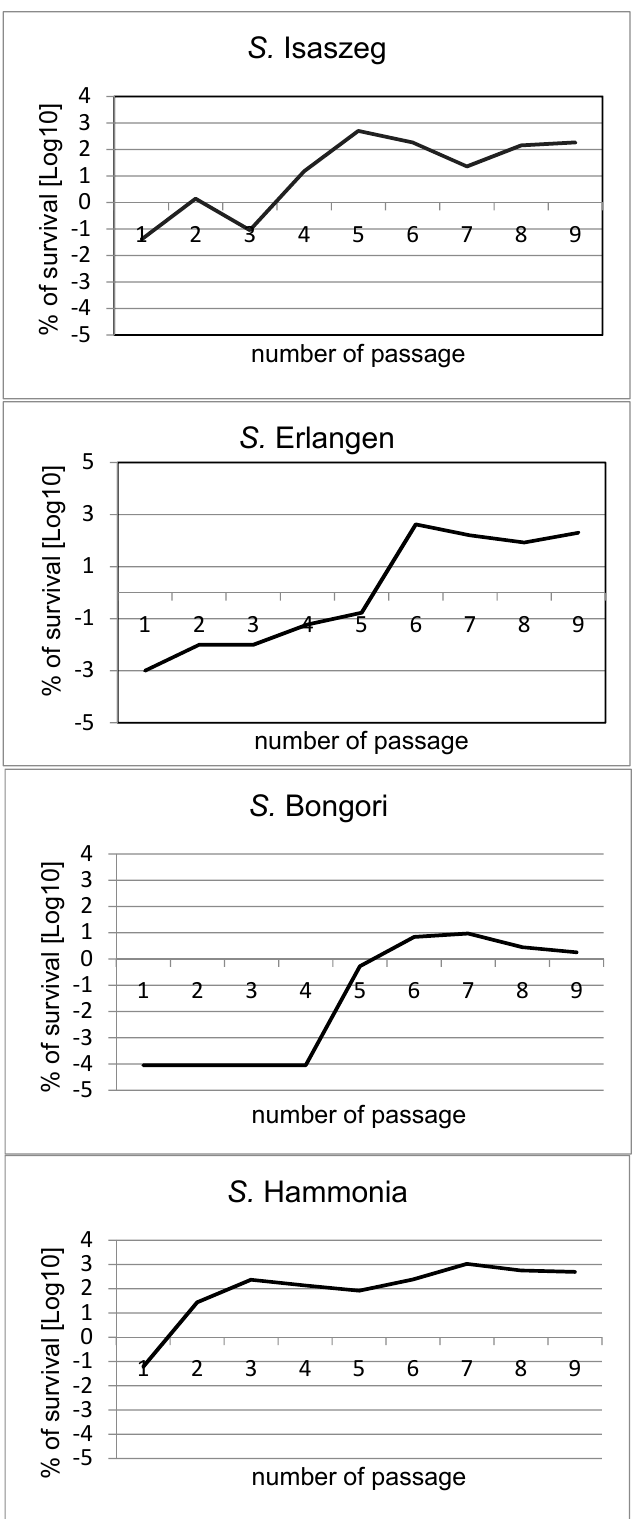
Figure 1. Survival percent of Salmonella O48 strains during nine passages in 50% NHS (normal human serum).